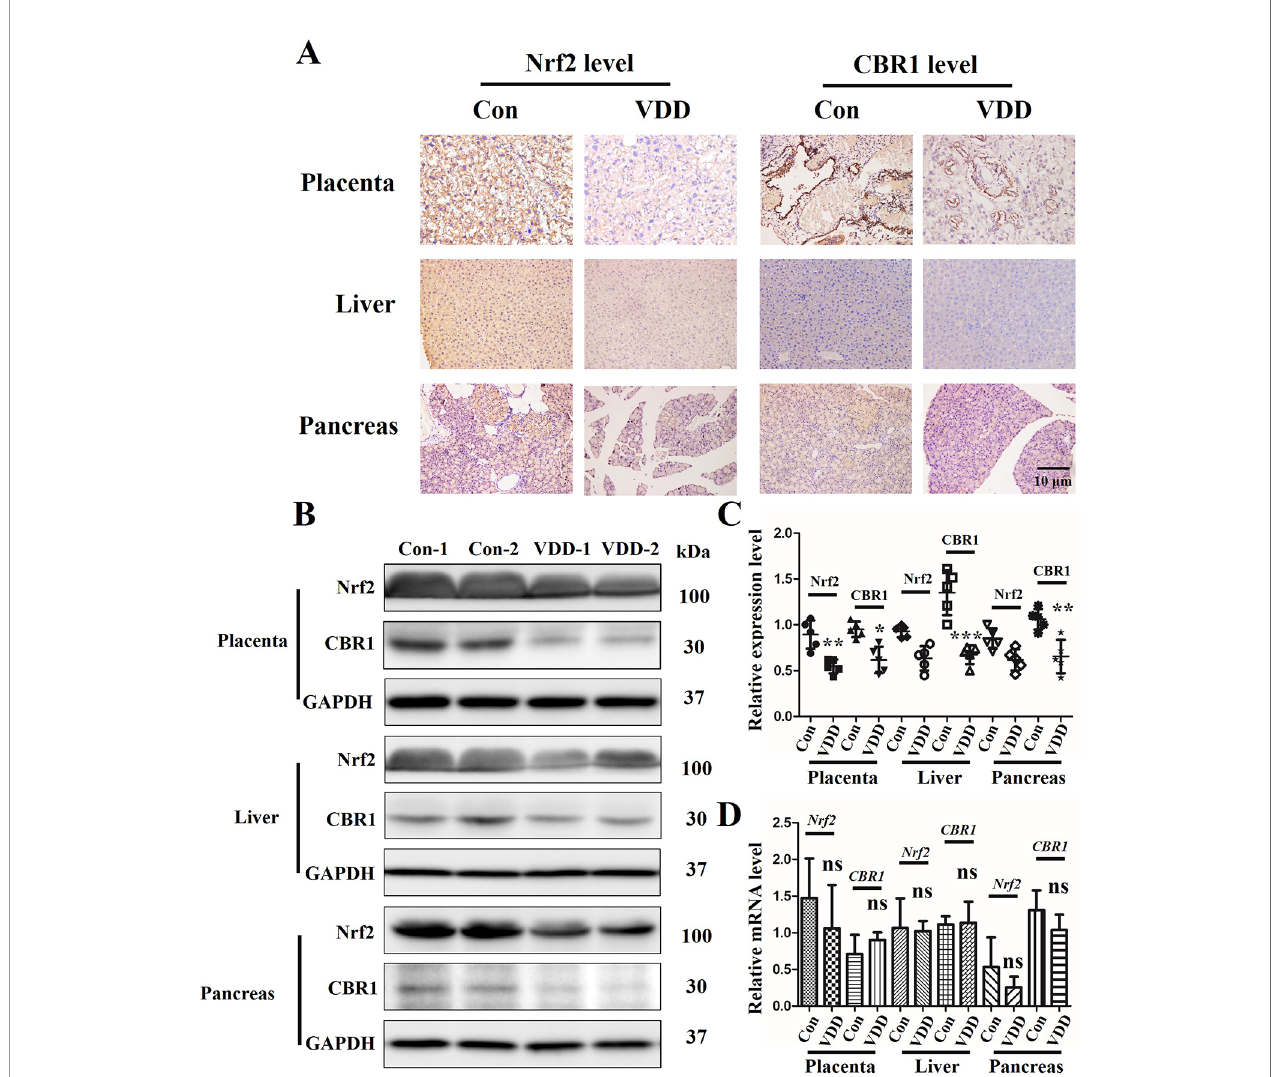
FIGURE 4 | The effect of Maternal 25-hydroxyvitamin D de fi ciency on the expression level of Nrf2 and CBR1 in maternal placenta, liver, and pancreas tissues. (A) Nrf2 and CBR1 immunohistochemical staining in maternal placenta, liver, and pancreas tissues obtained in normal group and 25-hydroxyvitamin D de fi ciency group (magni fi cation, ×200). (B – D) Application of Western blot (B , C) and qT-PCR (D) to ascertain the protein and mRNA expression levels, respectively, in maternal placenta, liver, and pancreas tissues. Mean ± SD, n = 5 rat per group. * P < 0.05, **P < 0.01, **P < 0.001 vs. control group; ns, no signi fi cance. Normal group, Con, Con-1, and Con-2 represent different rats; maternal 25-hydroxyvitamin D de fi ciency group, VDD, VDD-1, and VDD-2 represent different